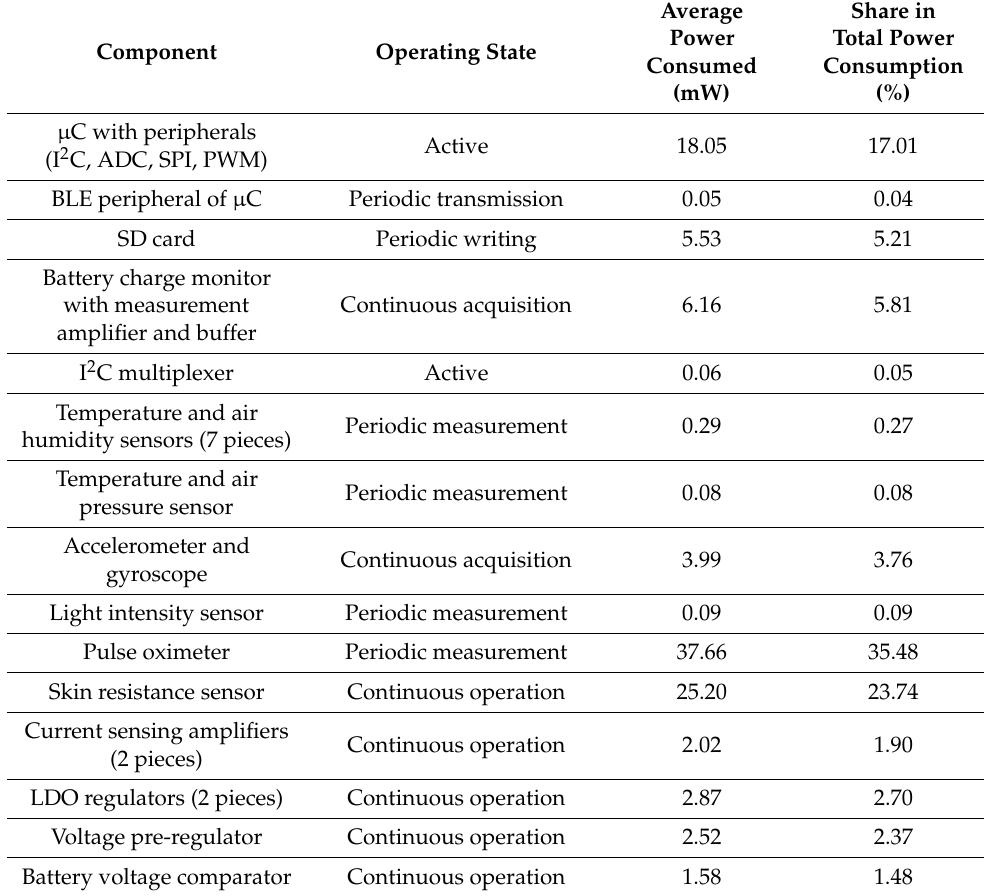
Table 2. Shares in estimated control module power